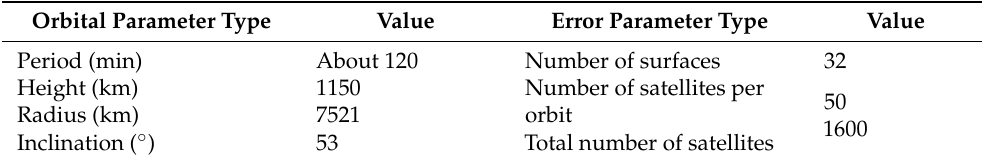
Table 1. The Core Constellation of SpaceX Parameters.